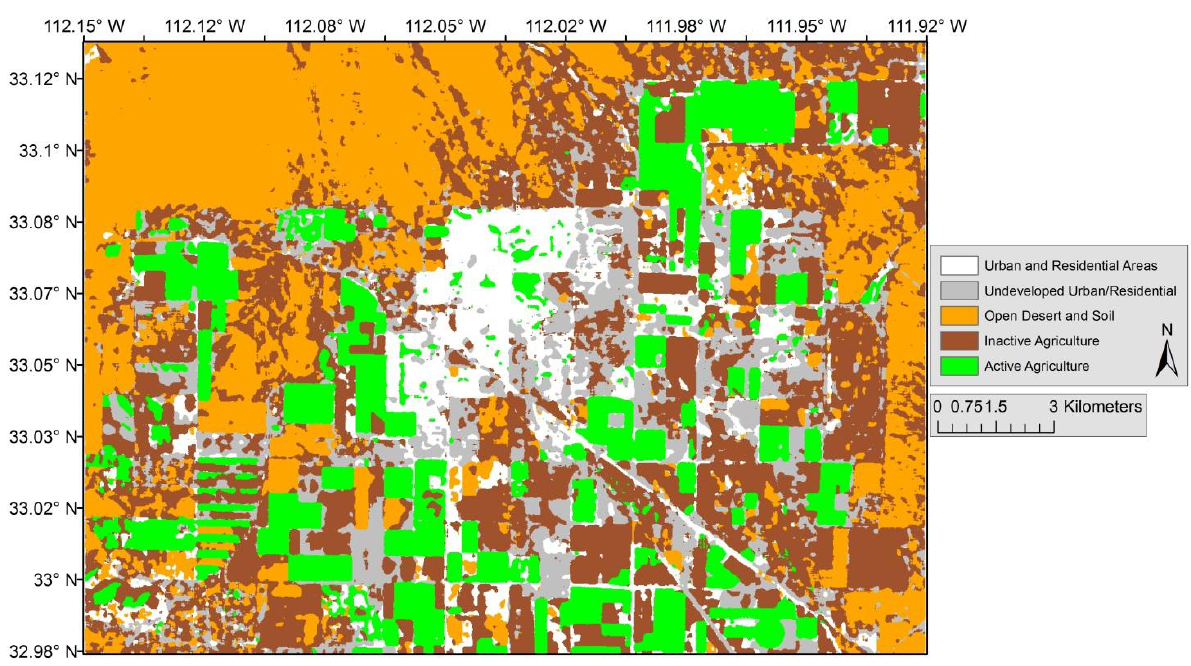
Figure 9. Unsupervised land-use classification (with majority